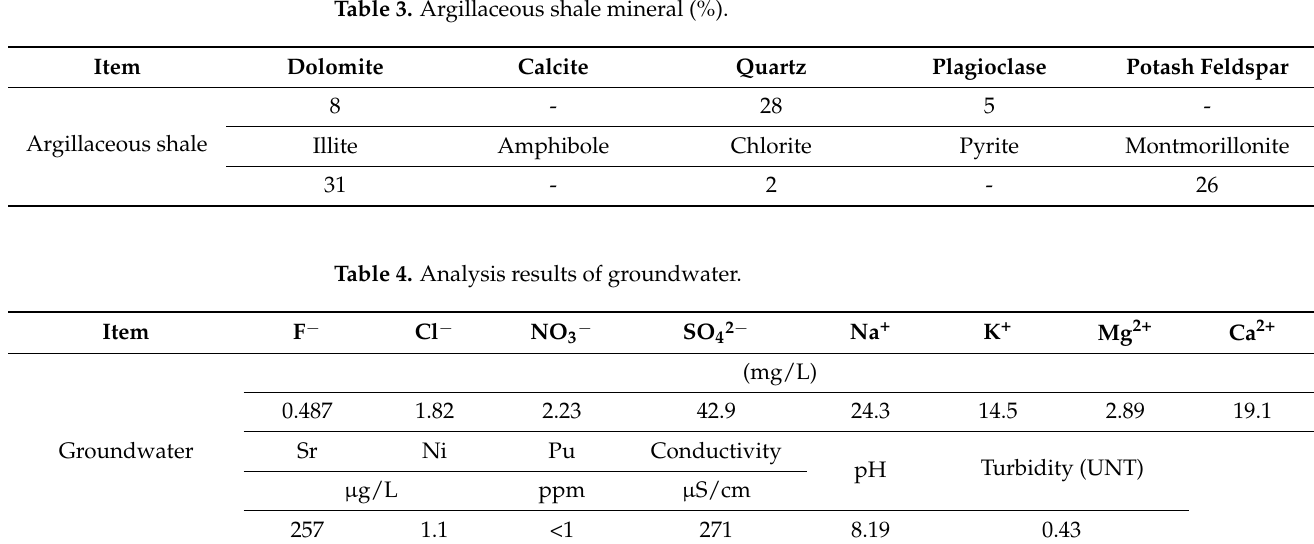
Table 3. Argillaceous shale mineral (%).